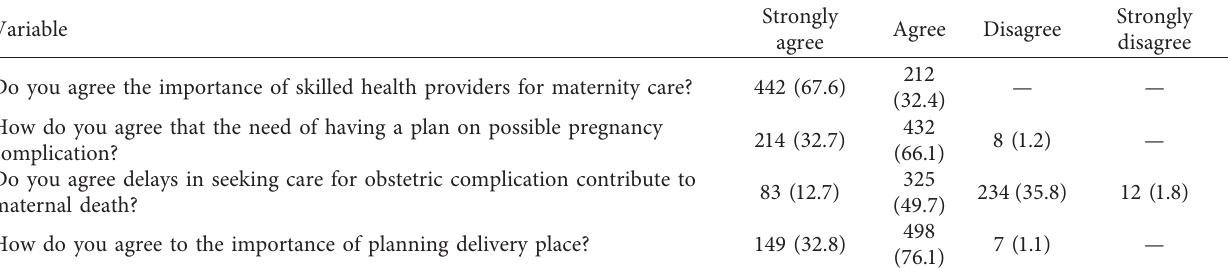
Table 3: Attitude towards skilled maternal healthcare among study participants.